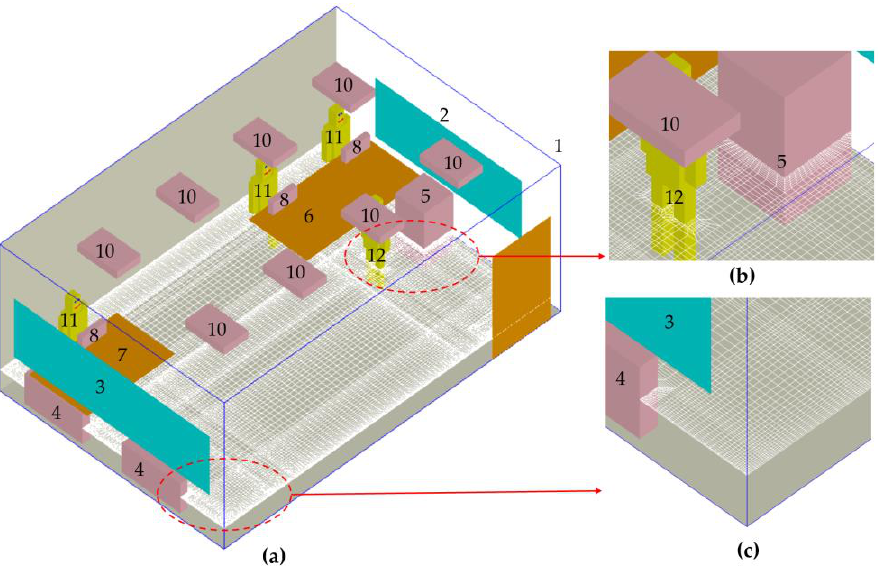
Figure 5. The 3D model and detailed mesh: ( a ) computational model; ( b , c ) drawing of partial en-